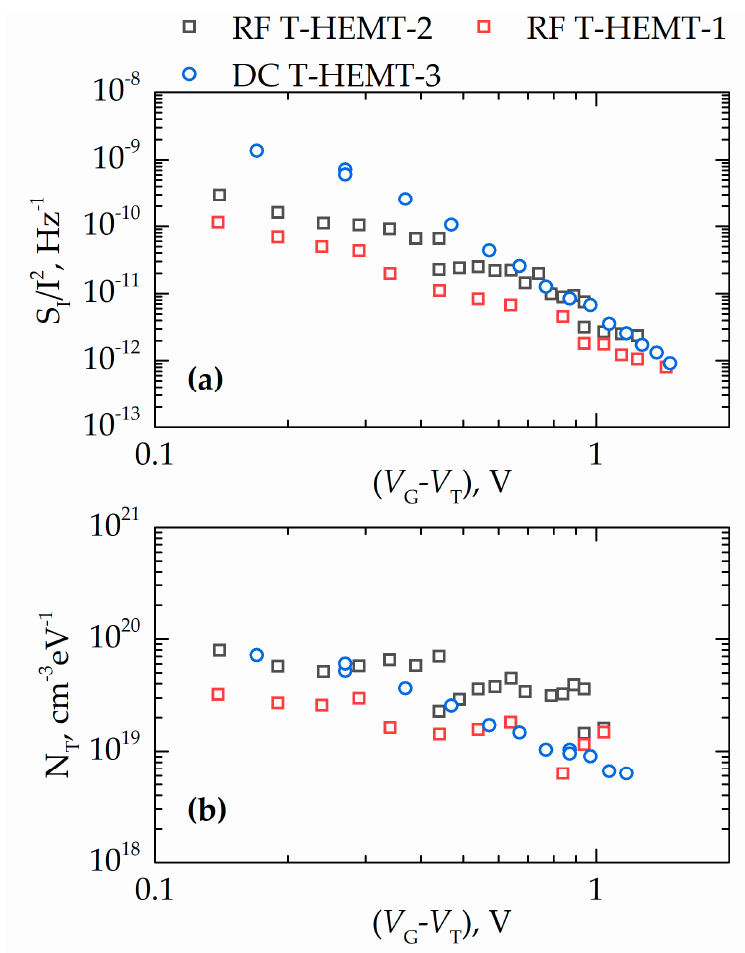
Figure 9. ( a ) Drain current noise S I / I 2 at frequency f = 10 Hz for T-HEMTs of different channel widths ranging from 0.2 mm to 0.6 mm and ( b ) the effective trap density N T as a function of the gate voltage swing ( V G -V T ) for the same